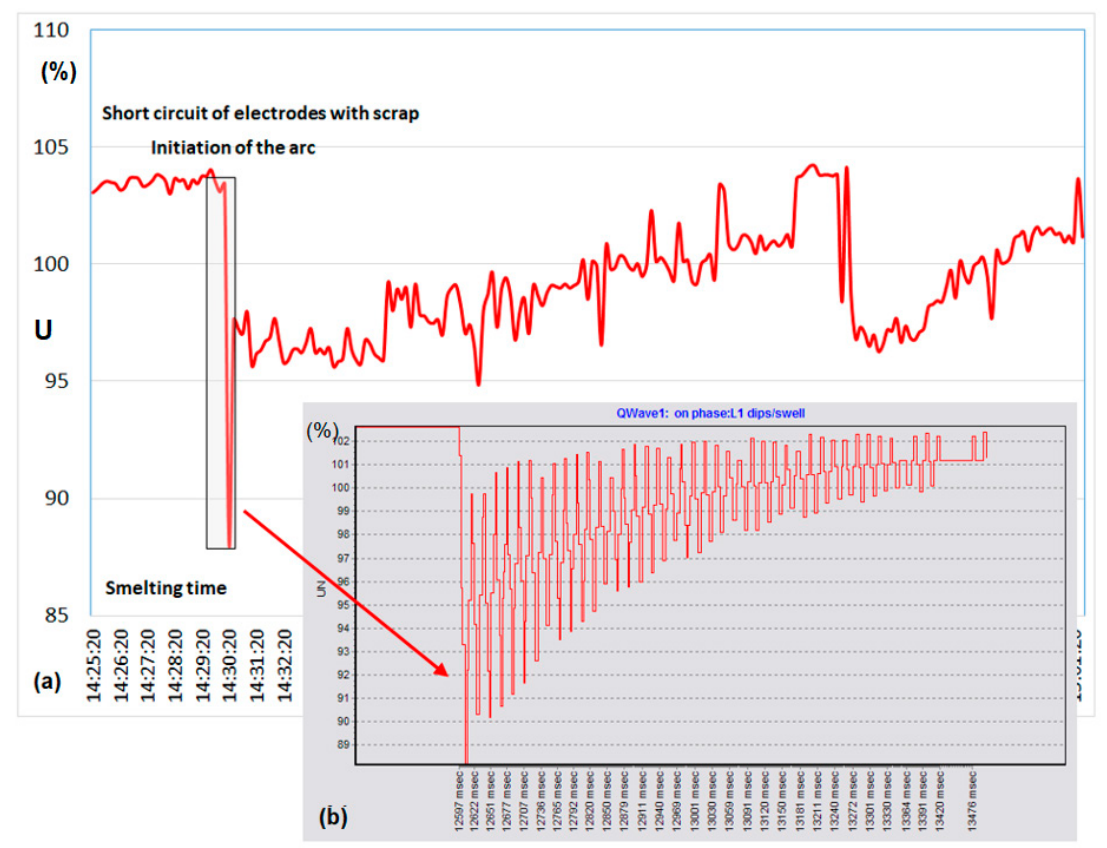
Figure 6. Voltage changes in the steel supply line ( a ) with indication of the electrode short-circuit period with charge ( b ).